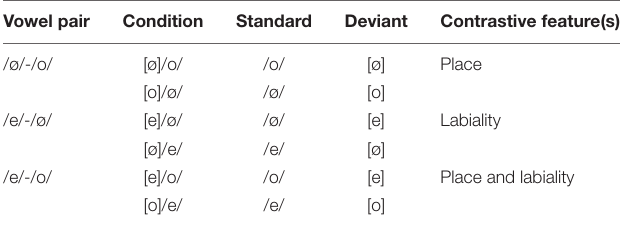
TABLE 1 | Overview of experimental conditions.